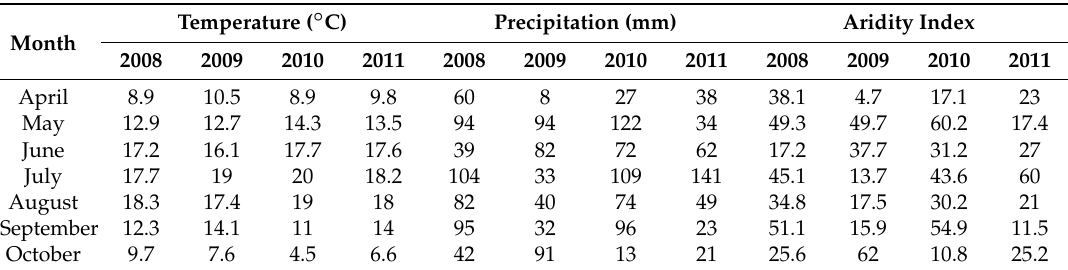
Table 1. Monthly average air temperature ( ◦ C), monthly precipitation (mm) and de Martonne aridity index during the 2008–2011 growing seasons at the Horyniec Zdr ó j weather station. Temperature ( ◦ C) Precipitation (mm) Aridity Month